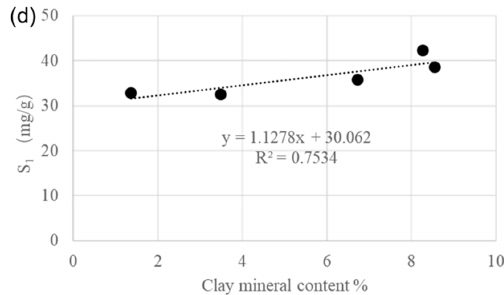
Figure 8. ( a ) The relationship between total porosity and oil content, S 1 peak of the studied samples. ( b ) The relationship between continuous porosity and the oil-bearing capacity, S 1 , of the studied samples. ( c ) The relationship between permeability and the oil content (S 1 ) of the studied samples. ( d ) The relationship between clay mineral content and the oil content (S 1 ) of the studied samples.